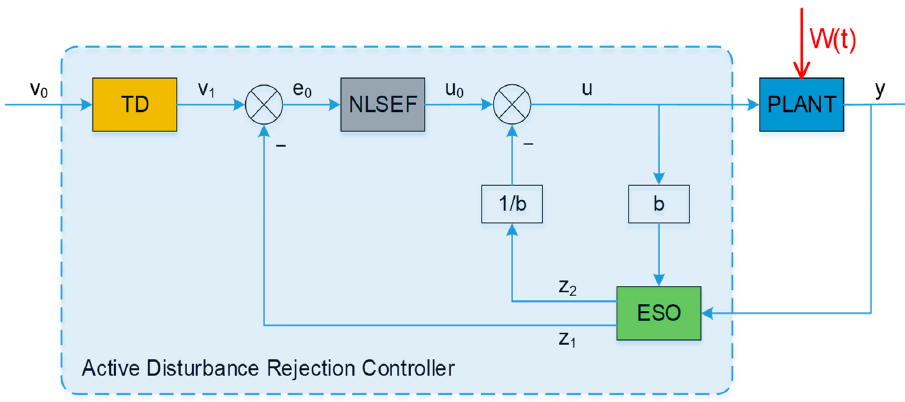
Figure 4. The basic control structure of ADRC.